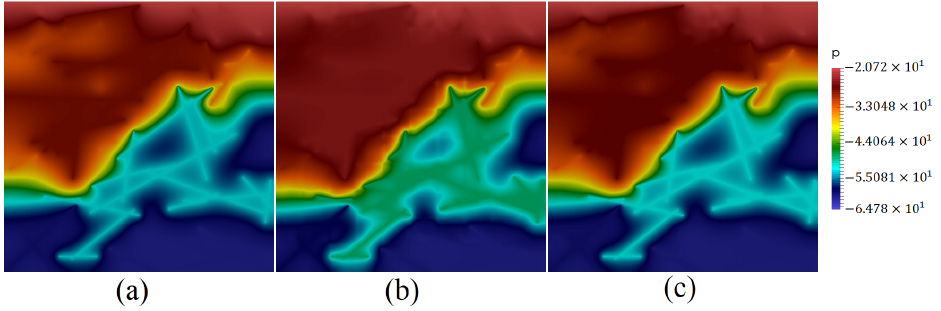
Figure 9. Numerical results for Test 3 . ( a ): fine grid solution. ( b ): multiscale solution using 12 offline basis functions. ( c ): multiscale solution using 12 offline basis functions and 1 online basis